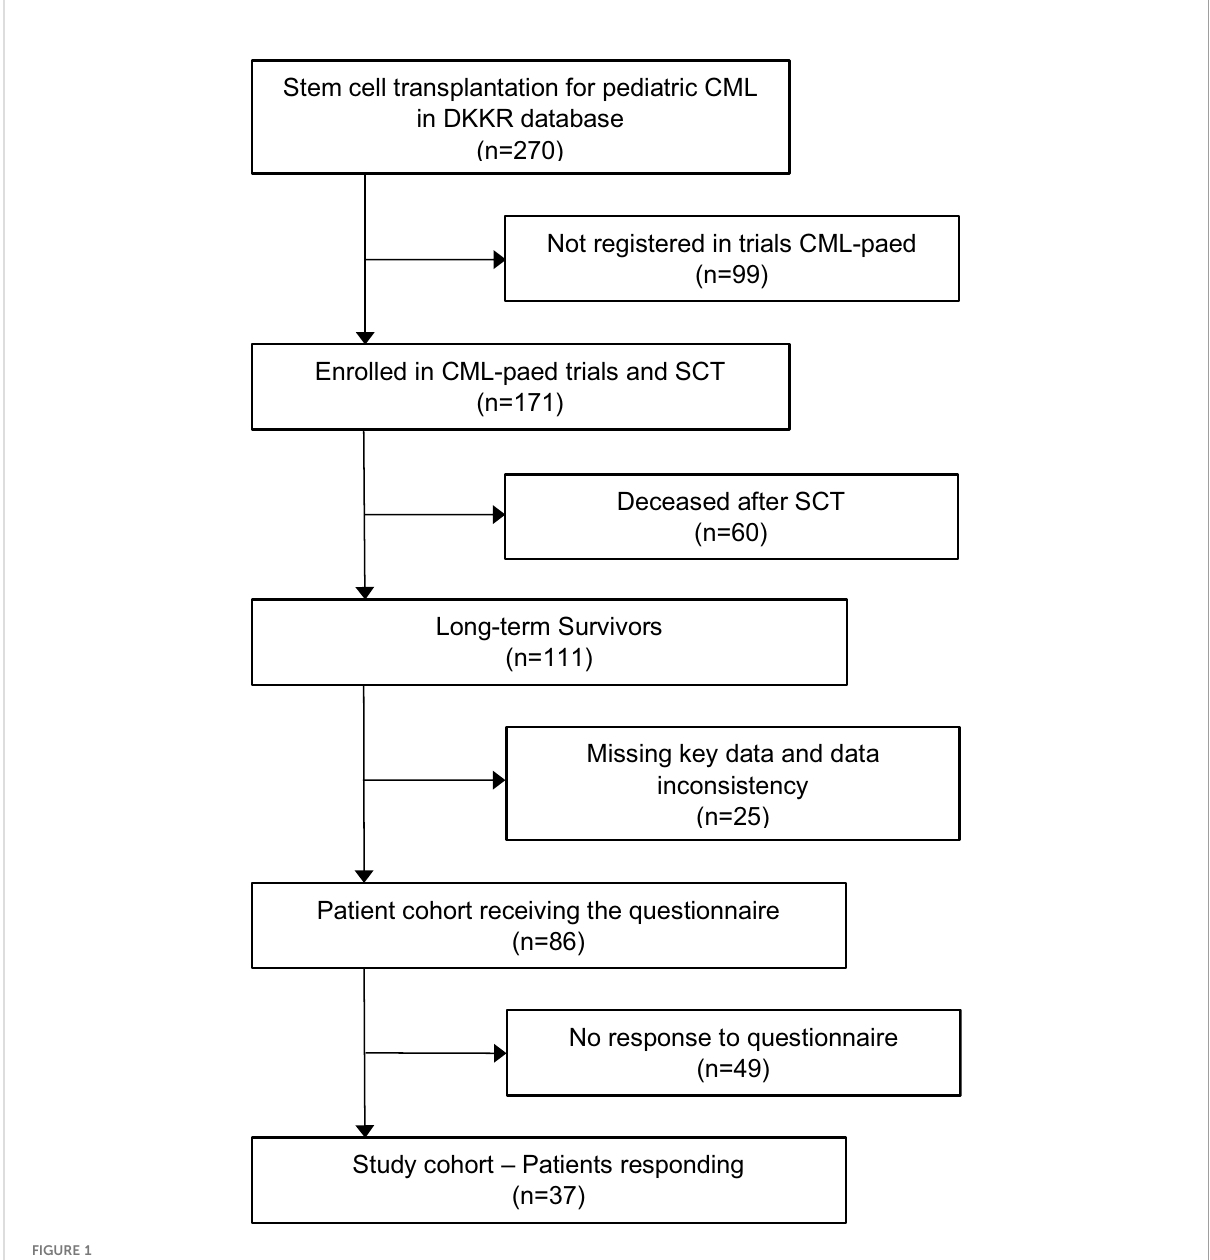
FIGURE 1 Consort diagram illustrating the recruitment of the participants into the